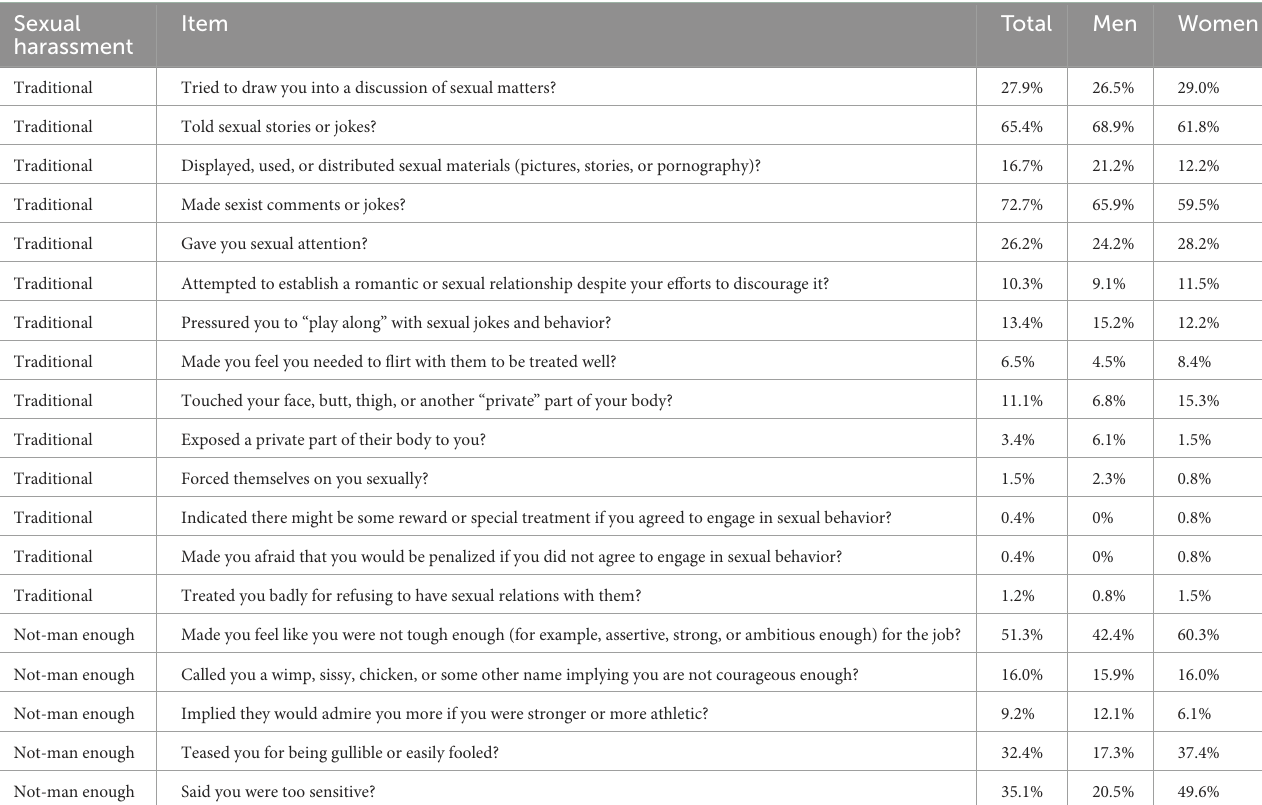
TABLE 1 Prevalence of sexual harassment in professional service firms ( N = 321). Sexual harassment